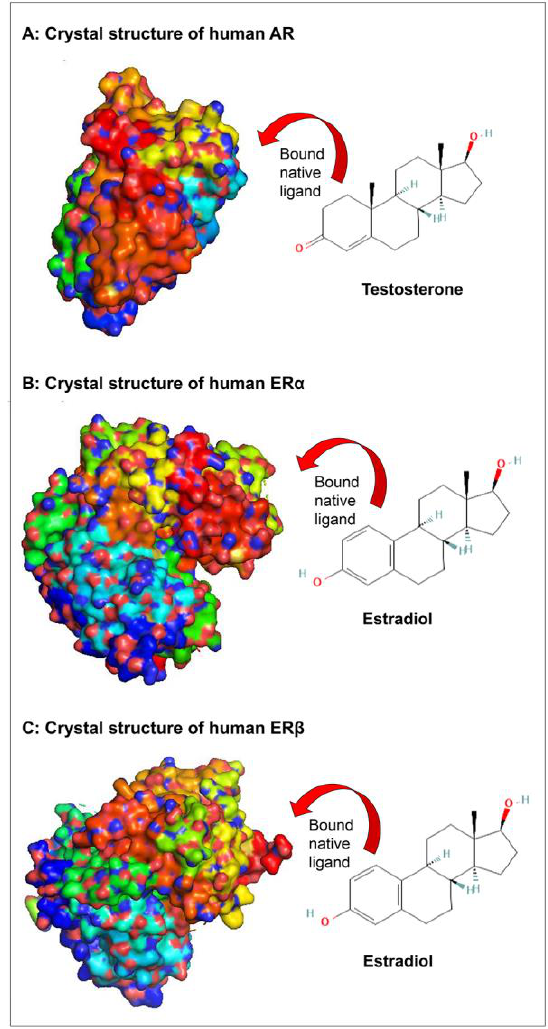
Figure 2. Surface representation of crystal structure of sex steroid hormone receptors containing the bound native ligands in the respective binding sites. Panel ( A ): crystal structure of human androgen receptor (AR) ligand binding domain in complex with testosterone; Panel ( B ): crystal structure of human estrogen receptor α (ERα) ligand binding domain in complex with estradiol; and Panel ( C ): crystal structure of human estrogen receptor β (ERβ) ligand binding domain in complex with estradiol.